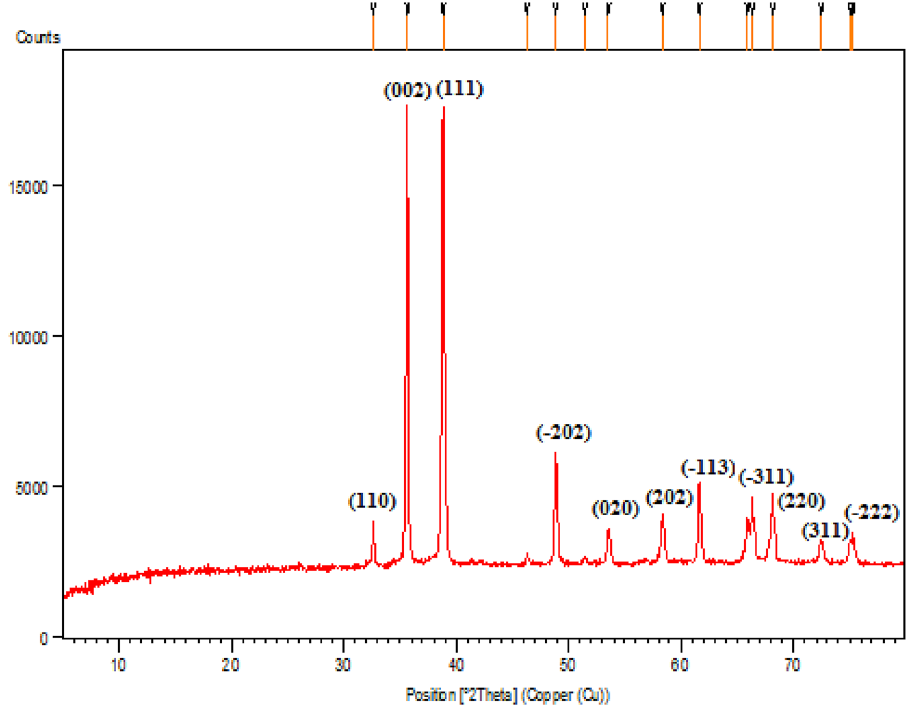
Figure 8. Powder XRD pattern of biogenic CuO NPs.